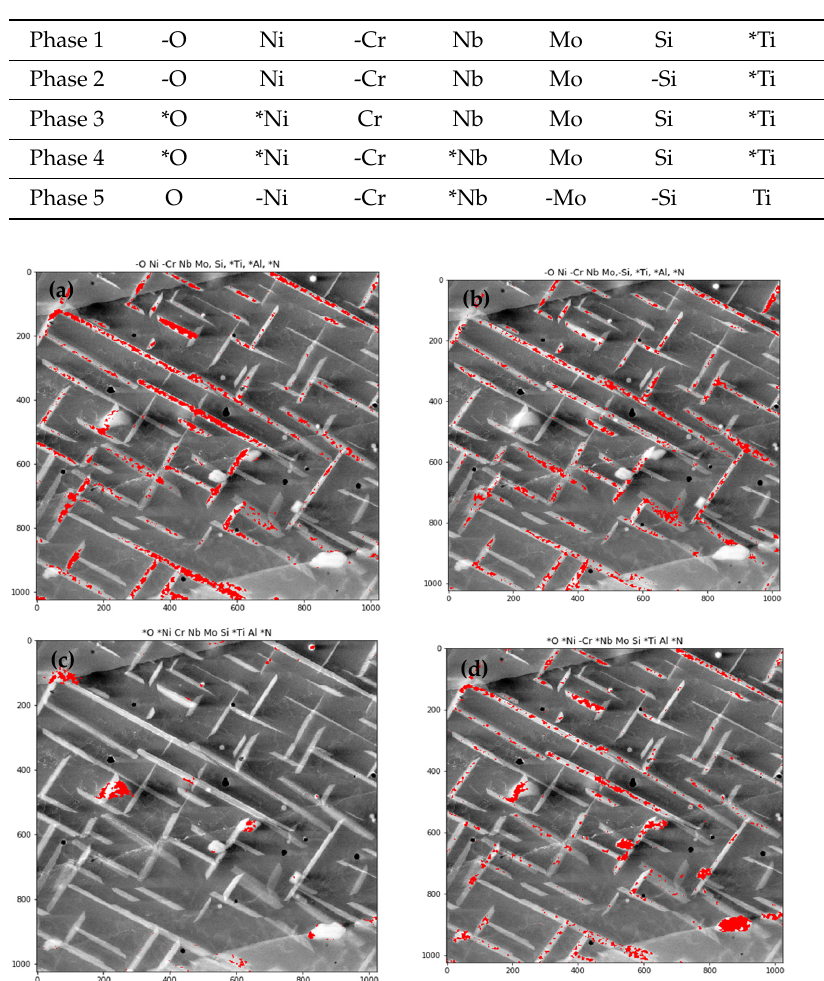
Table 5. Phases groups. Sign ‘-’ indicates “not increased”, no sign indicates “increased”, and ‘*’ sign indicates “not relevant”.